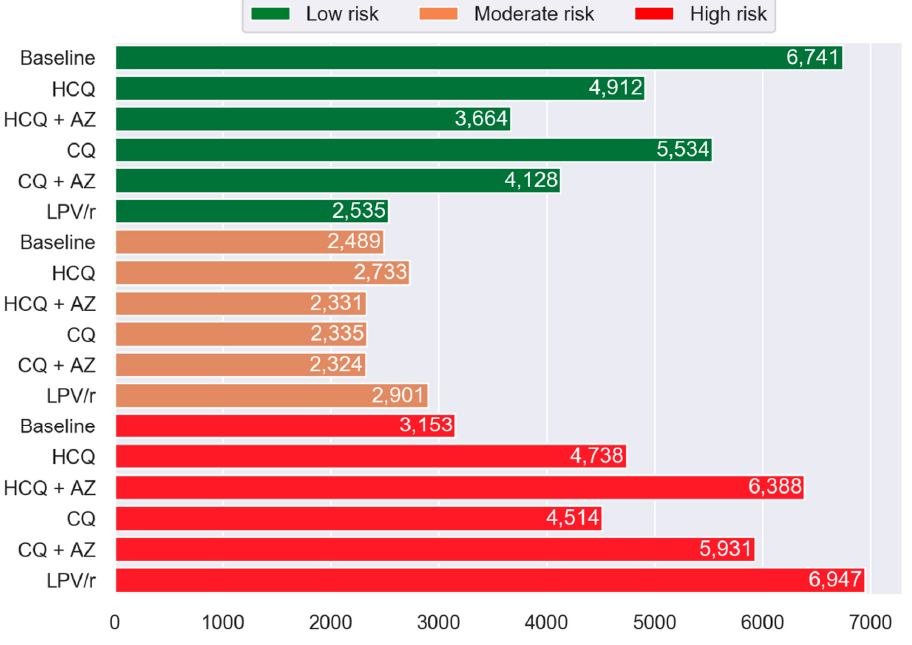
Figure 2. Histogram showing the frequency of PACE participants in Low, Moderate, and High MRS™ categories by drug compared to the baseline. The green, orange, and red represent the Low-risk (MRS TM 0 to < 15), Moderate-risk (MRS TM ≥ 15 to < 20), and High-risk (MRS TM ≥ 20) group categories, respectively. Abbreviations: HCQ, hydroxychloroquine; AZ, azithromycin; CQ, chloroquine; and LPV / r, lopinavir + ritonavir.